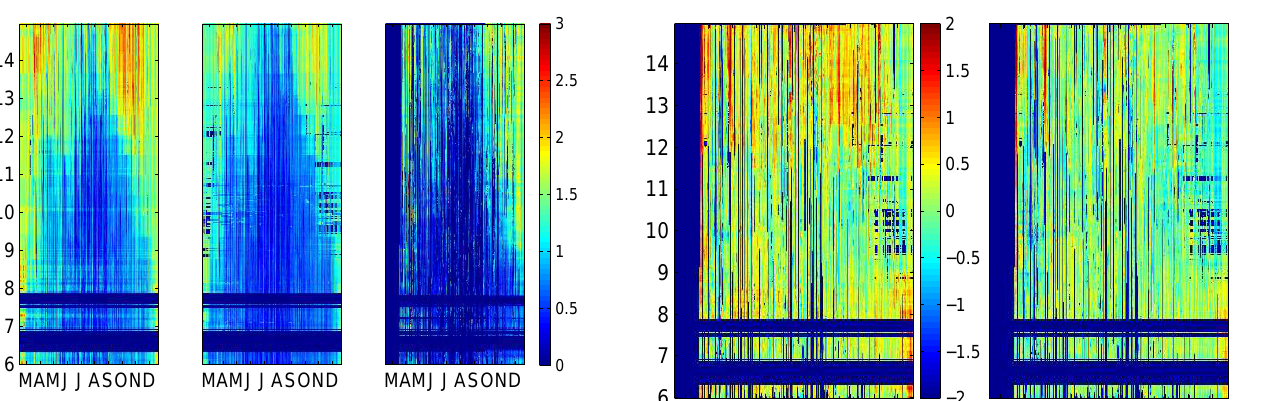
Fig. 12. Daily morning surface heating rates [Kh − 1 ] for a transect in West Africa from 15 ◦ N to 6 ◦ N: simulation using ECOCLIMAP- I (left) or LSA-SAF LAI (middle), obtained from LSA-SAF LST (right).